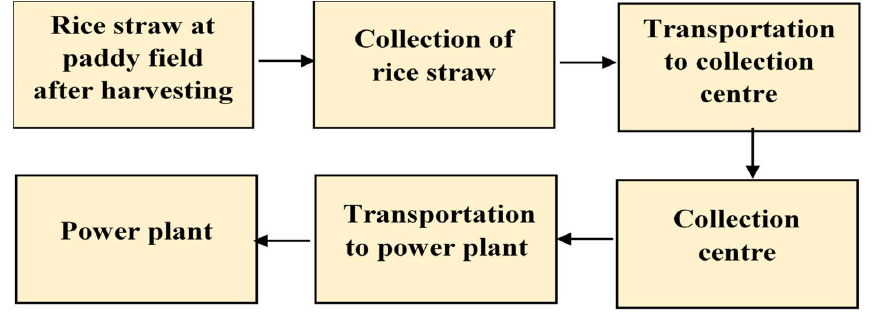
Figure 4. Overview of the logistical model [134] . 385